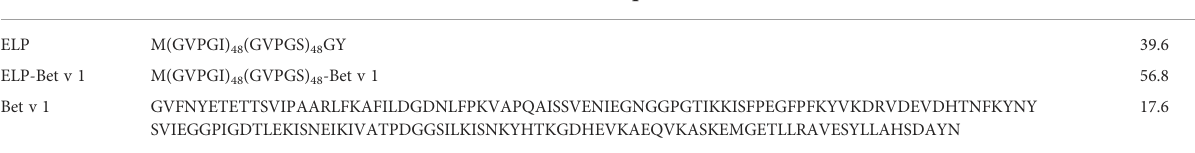
TABLE 1 Sequences of proteins used in this